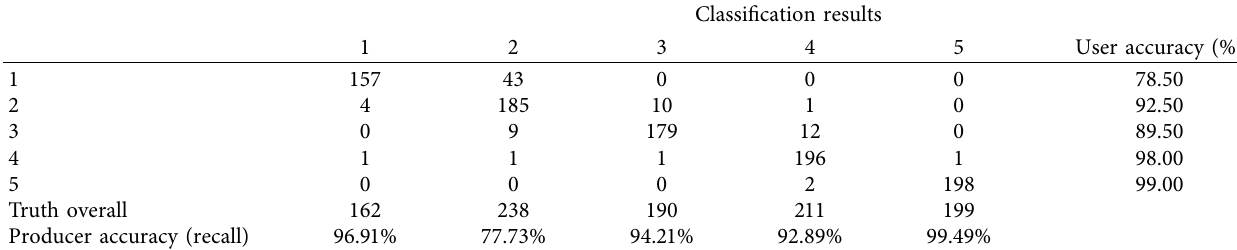
Table 5: dNBR confusion matrix in Banjarbaru. Classification results